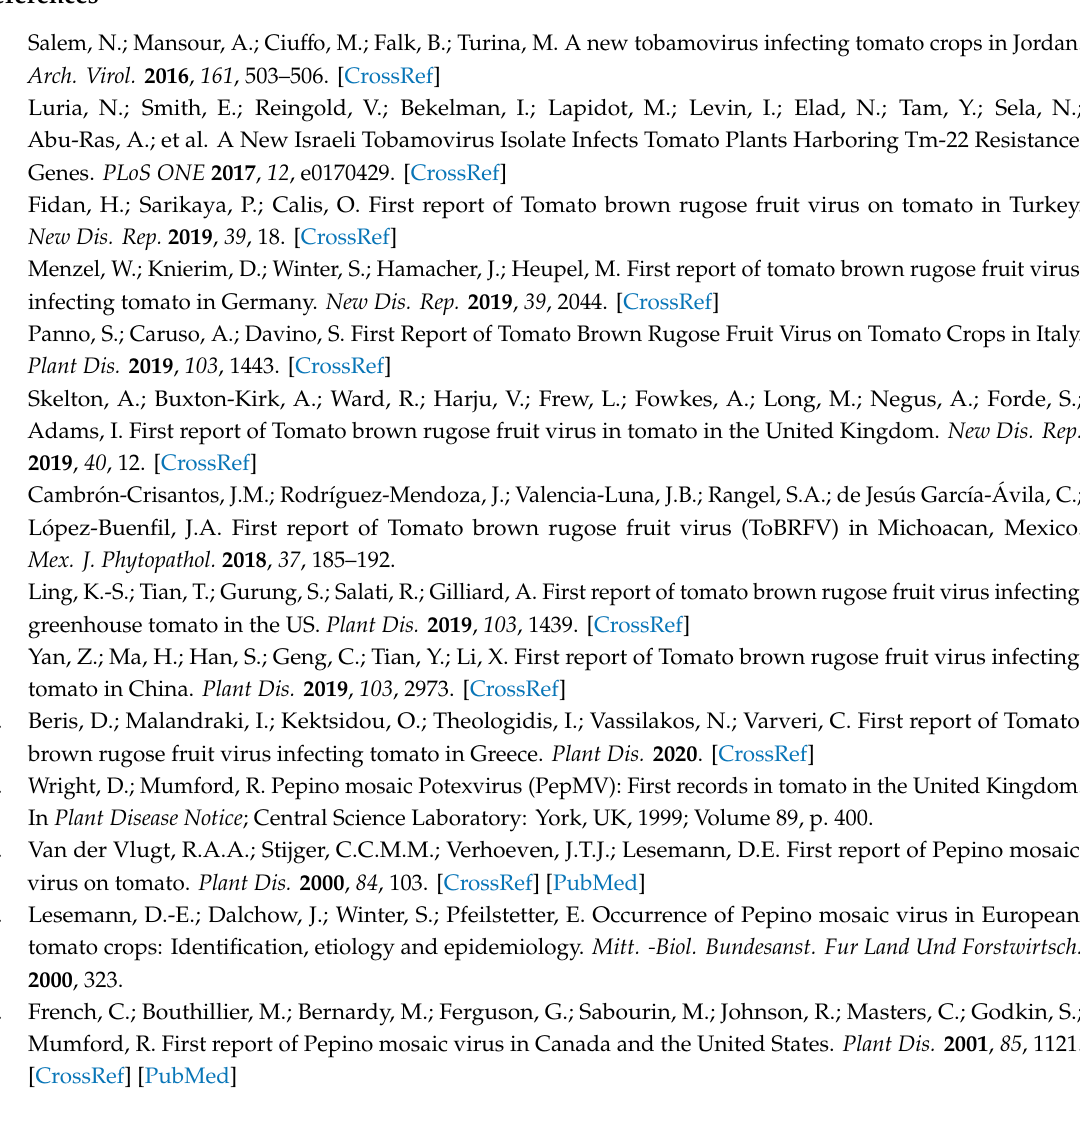
Table S1: Di ff erential deduced amino acids in six Israeli pepino mosaic virus isolates. Table S2: Relative gene expressions and relative gene expression ratios of tomato brown rugose fruit virus (ToBRFV) and pepino mosaic virus (PepMV), normalized to tomato endogenous gene TIP41 in mixed-infected tomato plants inoculated with a mixture of the viruses or sequentially, by pre-inoculations with PepMV or